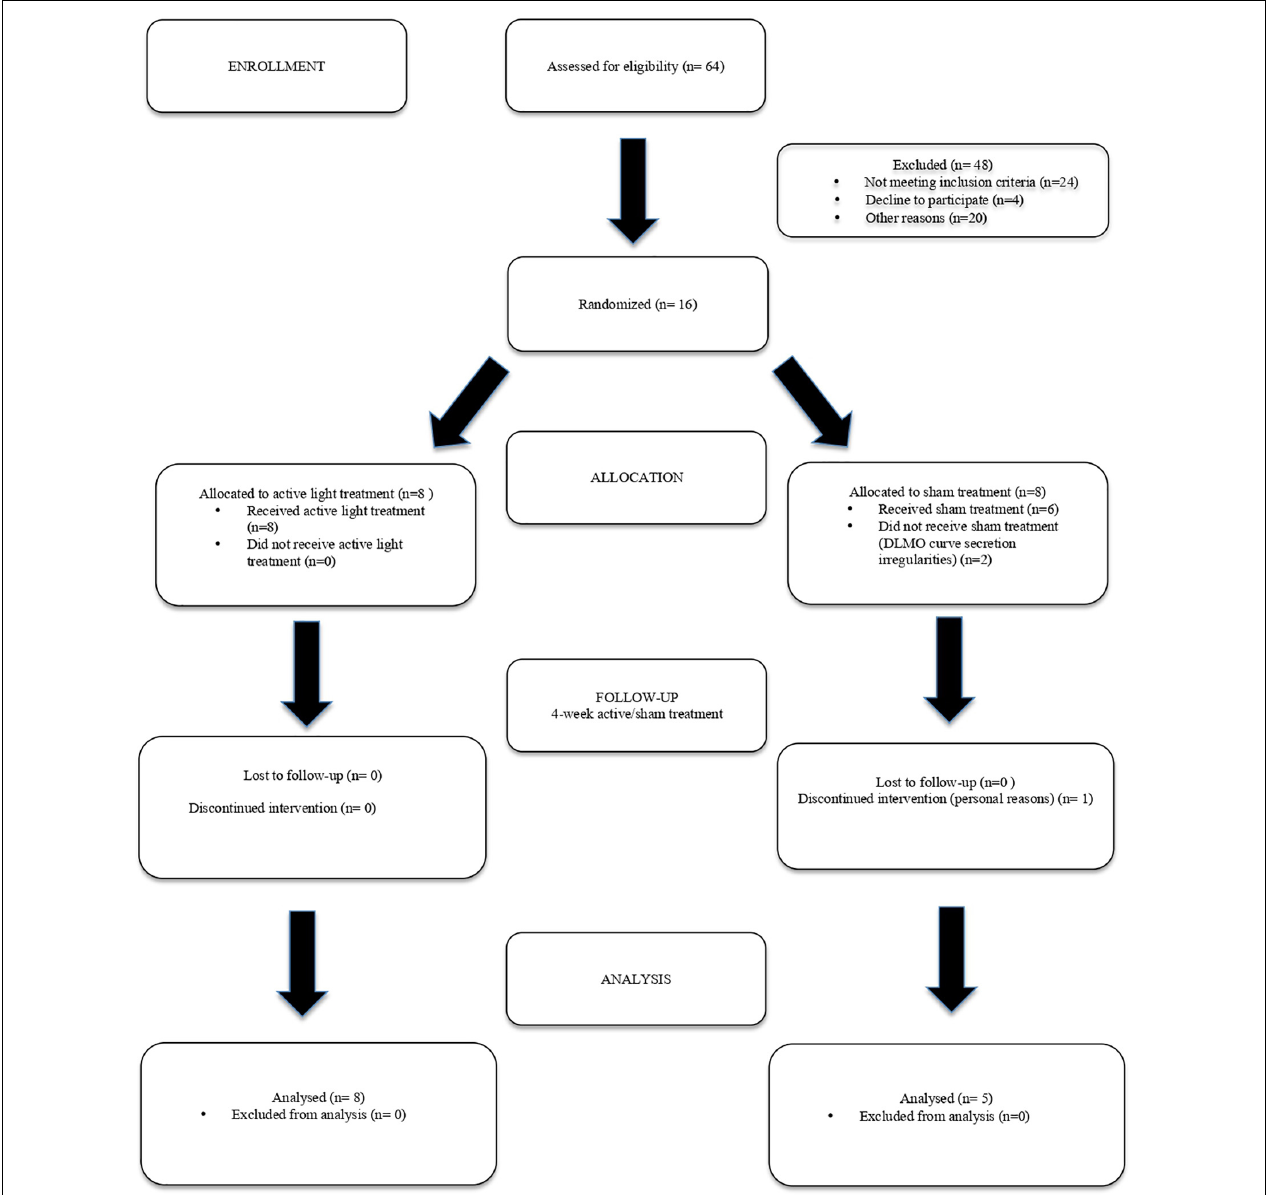
FIGURE 2 | Enrollment process flowchart of